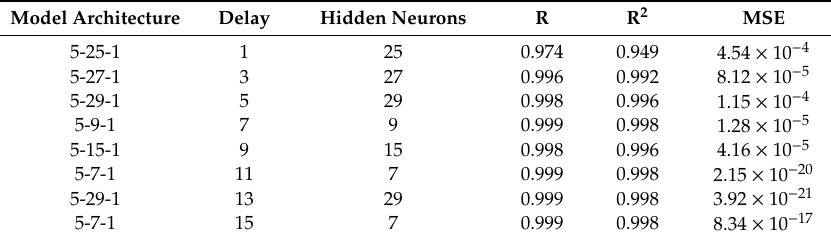
Table 2. Optimized hidden neuron obtained using data for